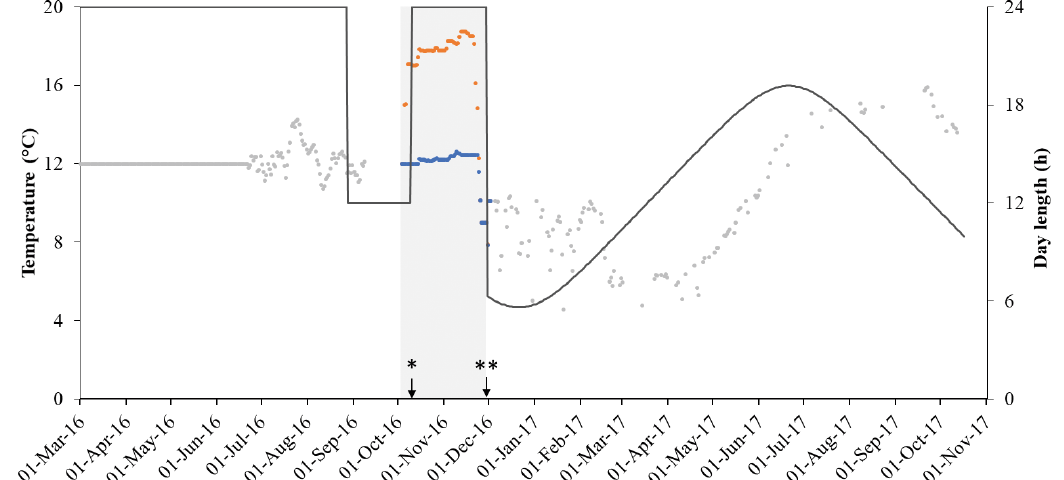
Fig. 1. Temperature (dots) and photoperiod (solid line) during the experiment. The grey zone represents the period of O 2 satu- ration (see Table 1) and temperature manipulation. Here, half of the fish were held at ~17°C (orange) and the other half at ~12°C (blue); otherwise, the fish were reared under a common temperature (grey dots). * Time of vaccination and ** fish transferred to common-garden rearing within a